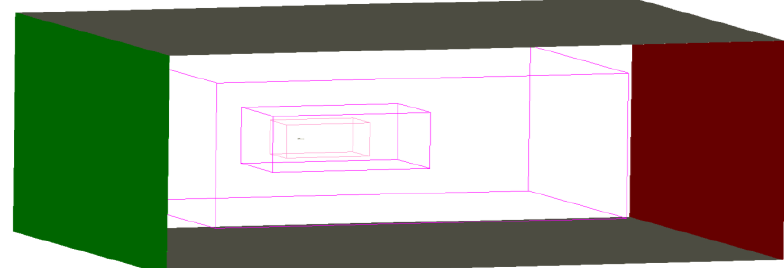
Figure 3. Computational domain.